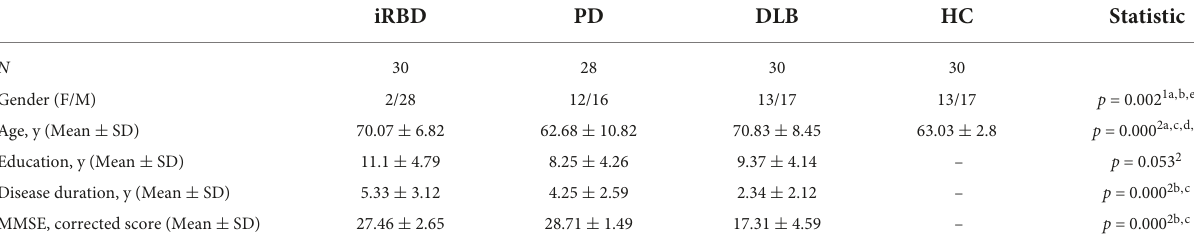
TABLE 2 Demographic and clinical features of the